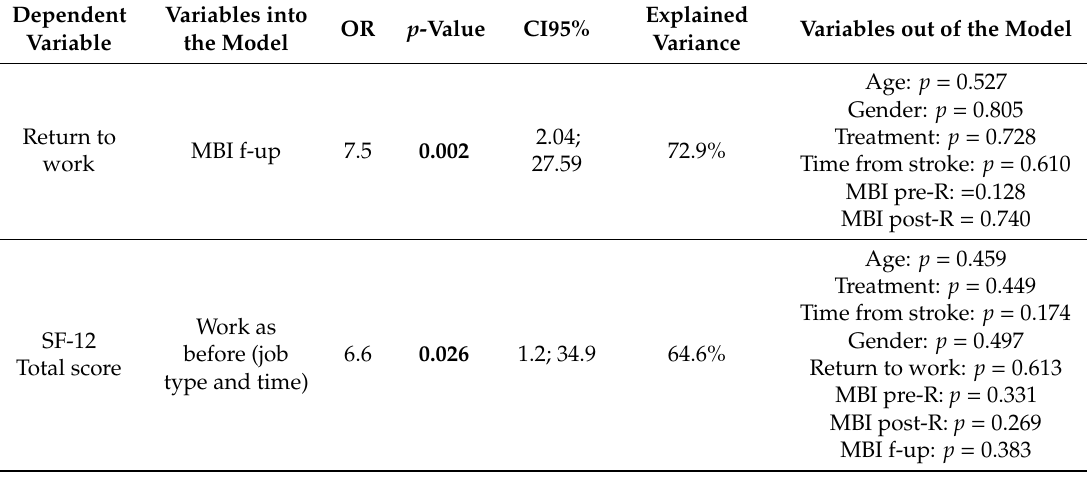
Table 4. Results of Forward Binary Logistic Regression (OR: odds ratio; CI95%: 95% confidence interval, p-Value in bold if statistically significant).